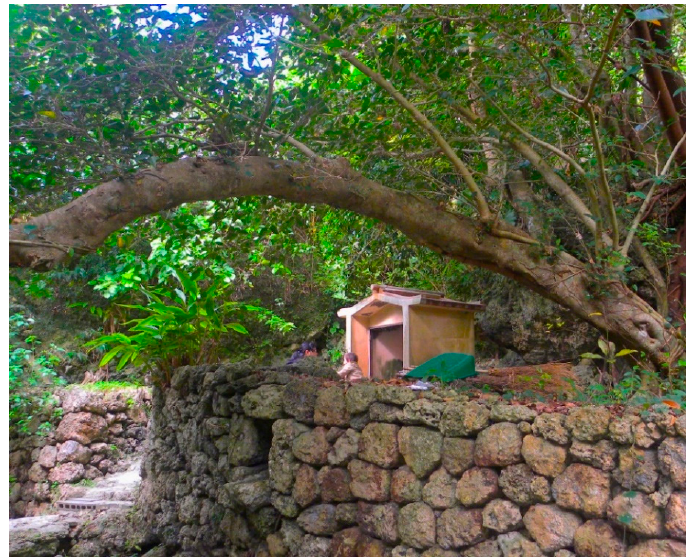
Figure 2. Hamagawa Utaki, a coastal grove in the south of Okinawa Island.